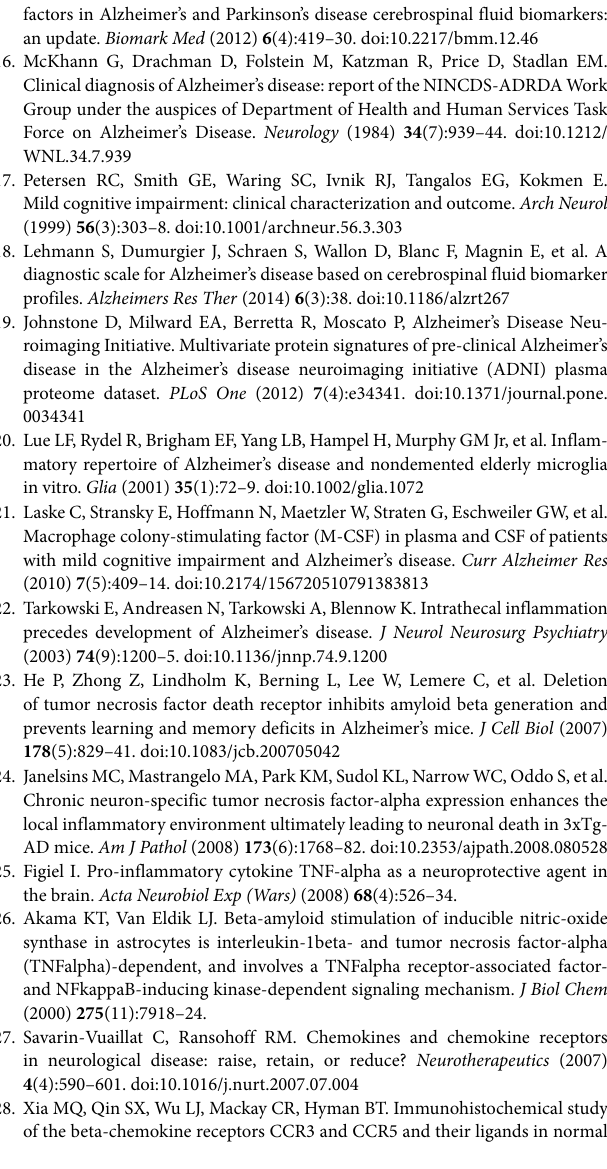
Table S1 | Antibody array map of G6 and G7 slides . Each array allowed for the detection and semi-quantitation of 60 human cytokines. POS and NEG correspond to positive and negative control, respectively, and are used for normalization of fluorescence detected from the